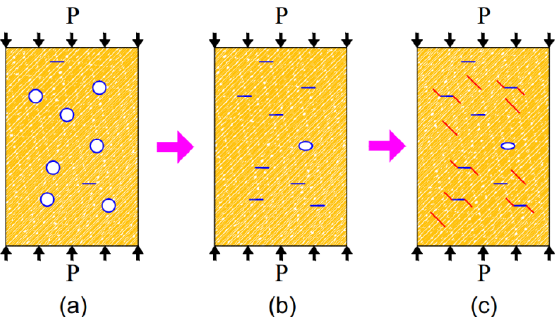
Figure 8. Schematic diagram of rock internal microcrack evolution: ( a ) initial microcracks; ( b ) the compacted initial microcracks; ( c ) new generated microcracks.